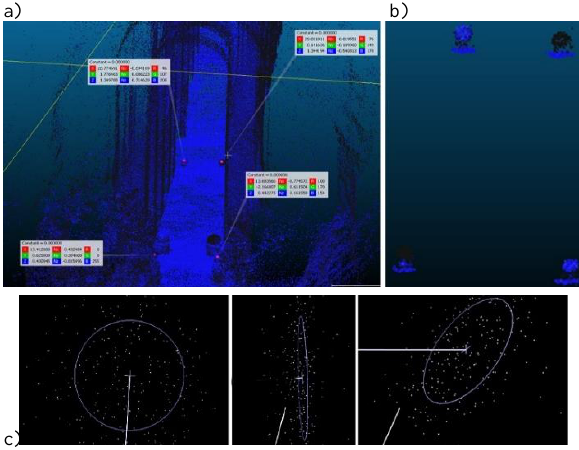
Figure 8: a-b) Selection of targets in the Zeb1 point cloud; c) Best fit